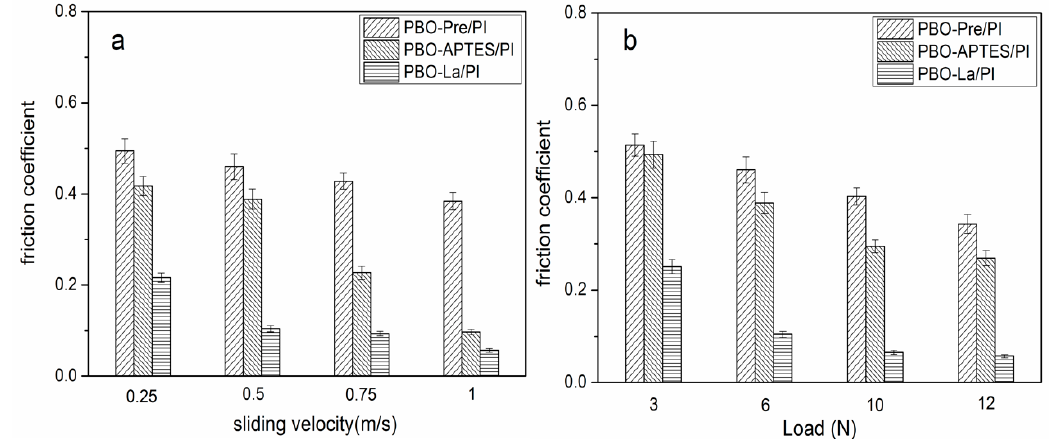
Figure 16. The friction coefficient of PI composites in a 260 °C environment as a function of ( a ) sliding velocity (load: 6 N) and ( b ) load (velocity: 0.5 m/s).